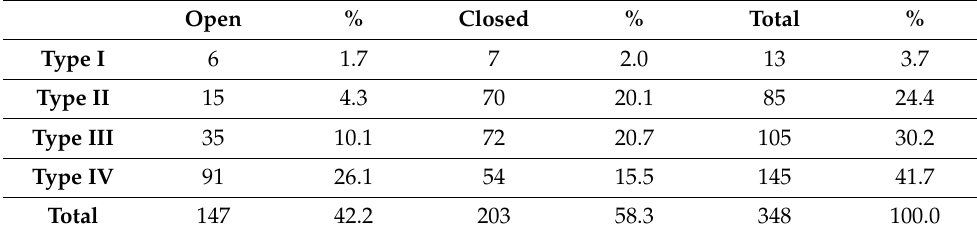
Table 4. Frequency of open and closed reduction according to fracture